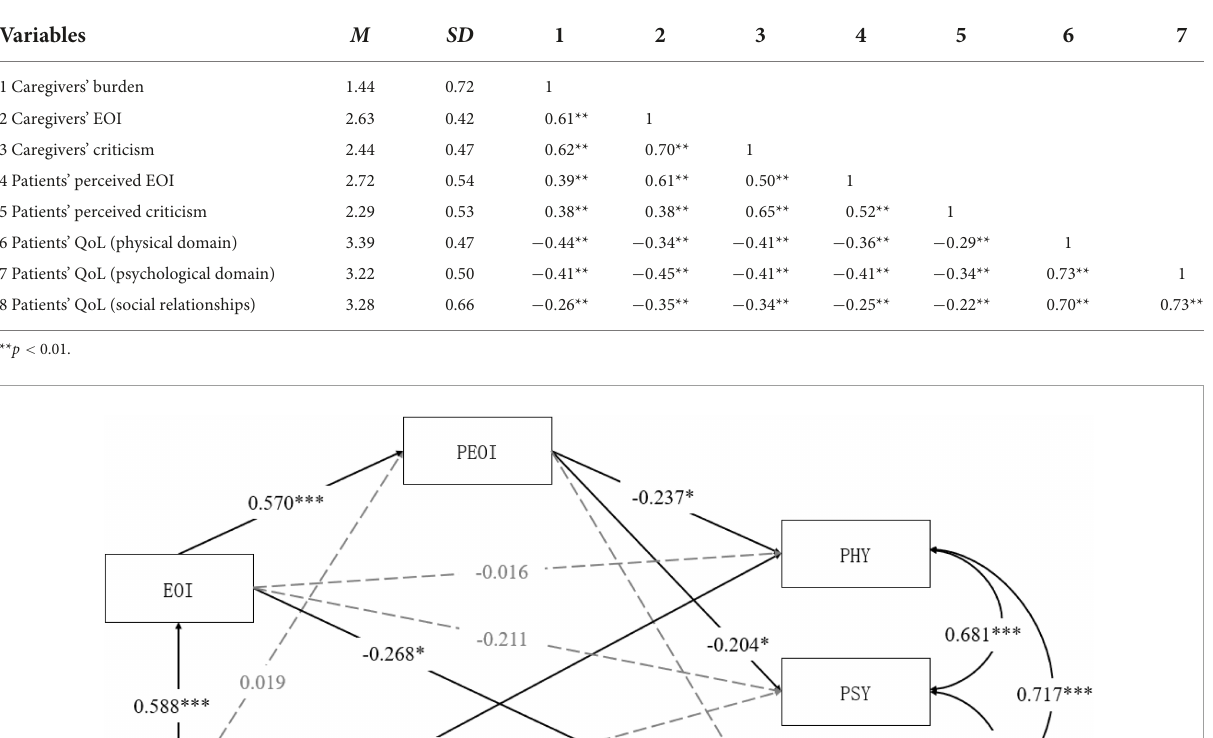
TABLE 2 Descriptive statistics and correlations ( N = 135).